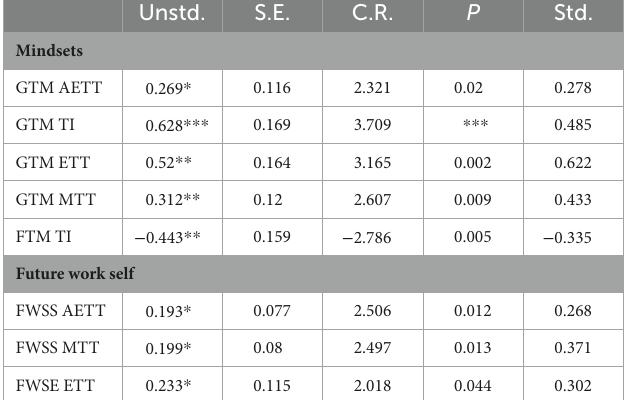
TABLE 11 Regression weights. Unstd. Std.